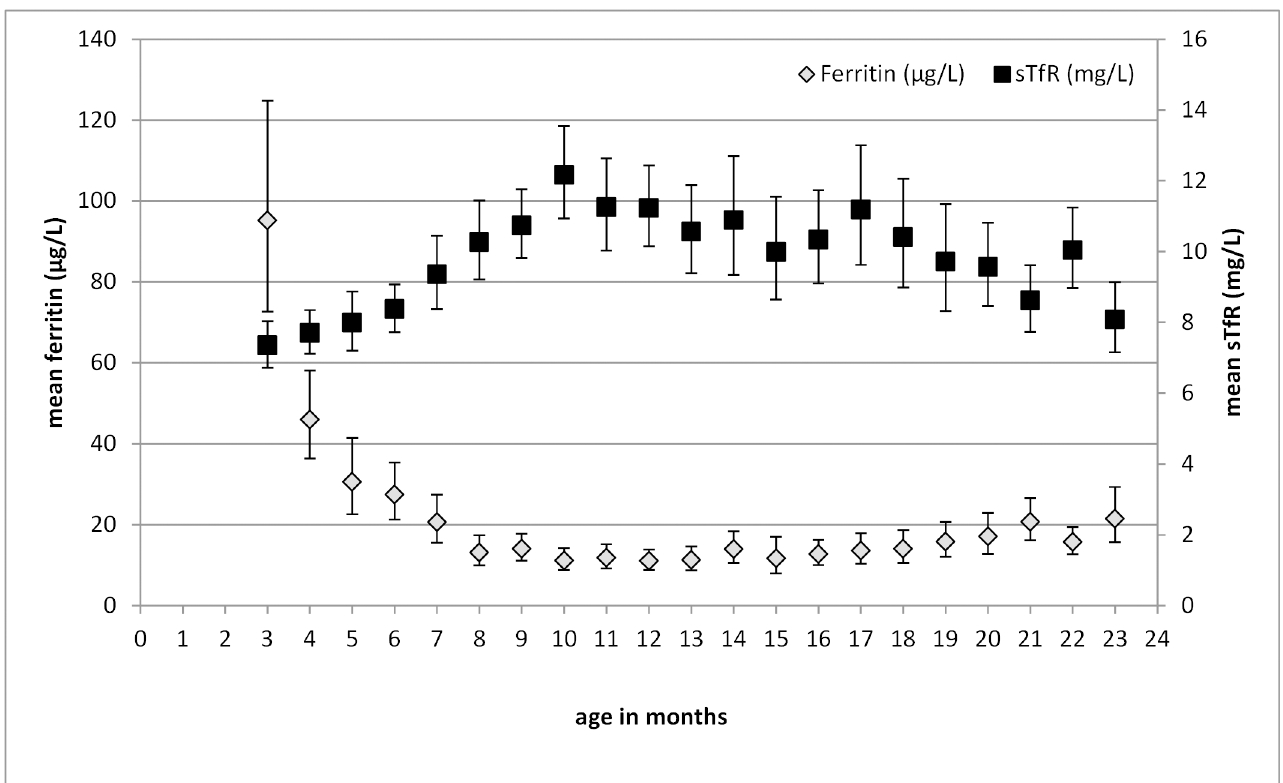
Fig 2. Geometric means of ferritin and sTfR concentrations by age in months. 3 mo: N = 38, 4mo: N = 45, 5mo: N = 39, 6mo: N = 52, 7mo: N = 55, 8mo: N = 55, 9mo: N = 57, 10mo: N = 57, 11mo: N = 55, 12mo: N = 60, 13mo: N = 53, 14mo: N = 44, 15mo: N = 28, 16mo: N = 46, 17mo: N = 32, 18mo: N = 29, 19mo: N = 26, 20mo: N = 37, 21mo: N = 42, 22mo: N = 40, 23mo: N = 33; mo = months.